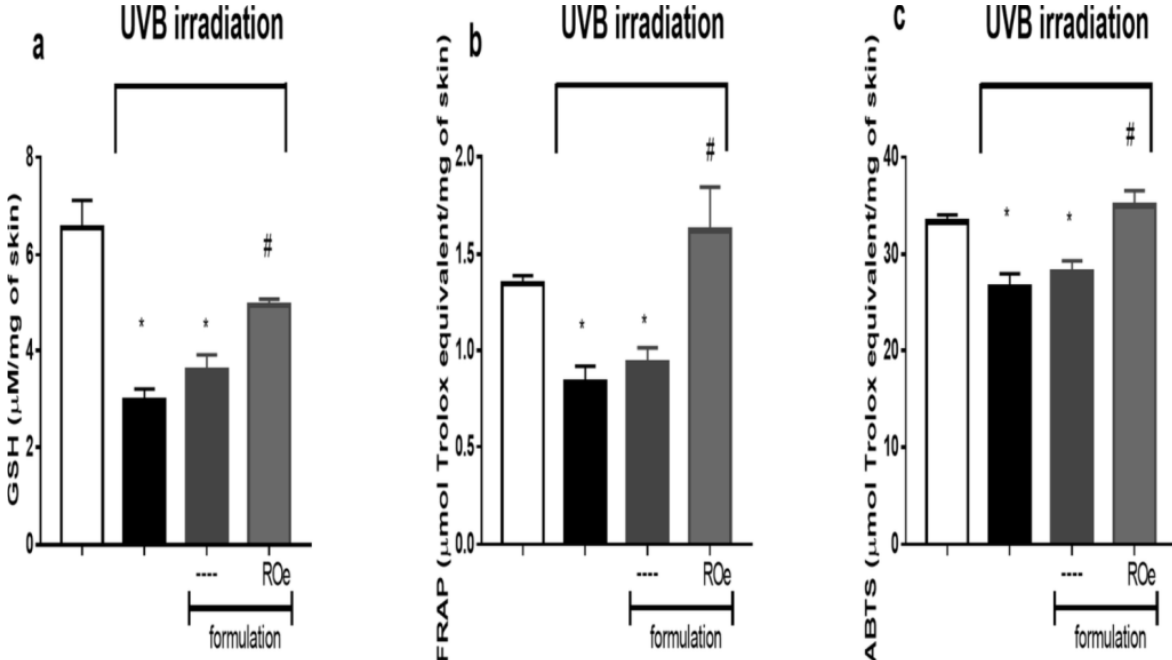
Figure 4. Effect of Topical formulation containing ROe on antioxidant capacity of skin after UVB irradiation. The antioxidant capacity was measured using GSH ( a ), FRAP ( b ) and ABTS ( c ) assays in samples collected 12 h after the end of irradiation. Bars represent means ± SEM of 5 mice per group per experiment and are representative of two separate experiments. * p < 0.05 compared to the non-irradiated control groups (white bars); # p < 0.05 compared to the irradiated control groups (black